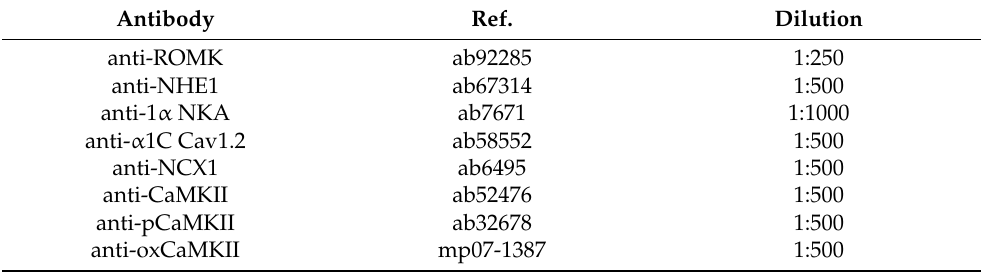
Table 2. Antibodies, commercial references (ab: Abcam; sc: Santa cruz; mp: Millipore; c-cst: Sigma) and conditions used concerning the proteins studied by western blot. Antibody